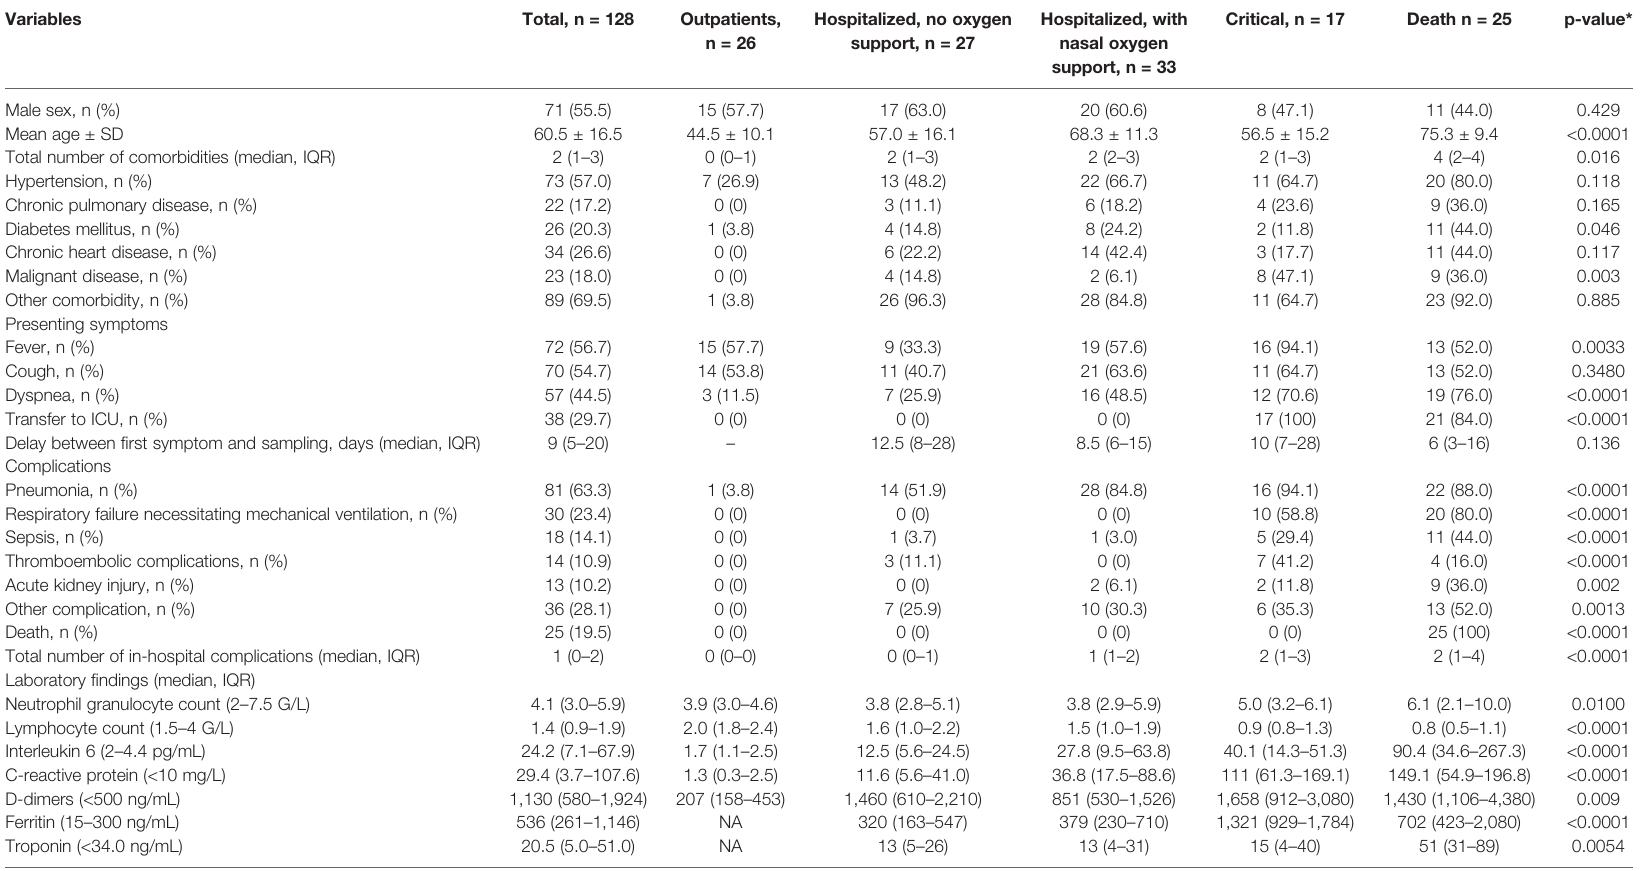
TABLE 1 | Basic characteristics of SARS-CoV-2 infected patients, comparison according to peak